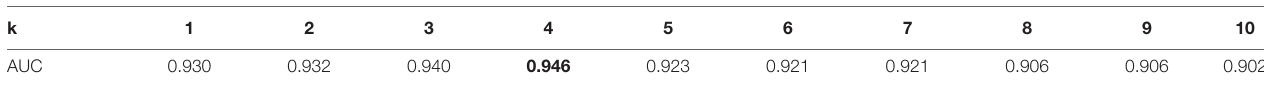
TABLE 2 | AUC with different values for parameter k